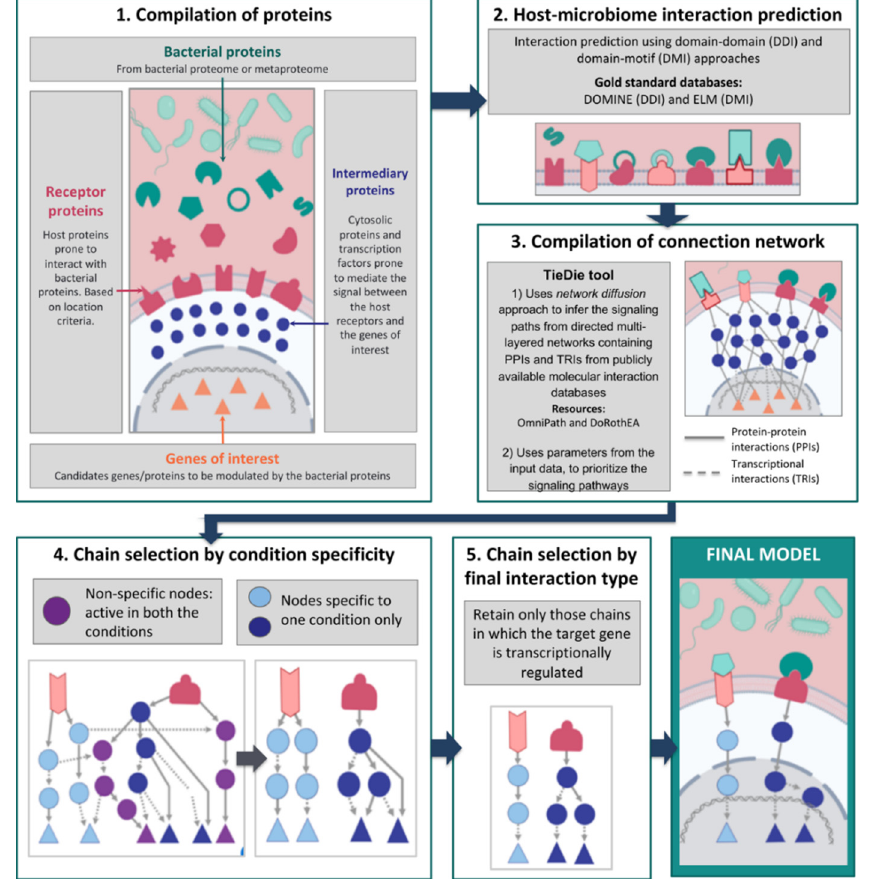
Figure 1. Graphical representation of the MicrobioLink workflow.